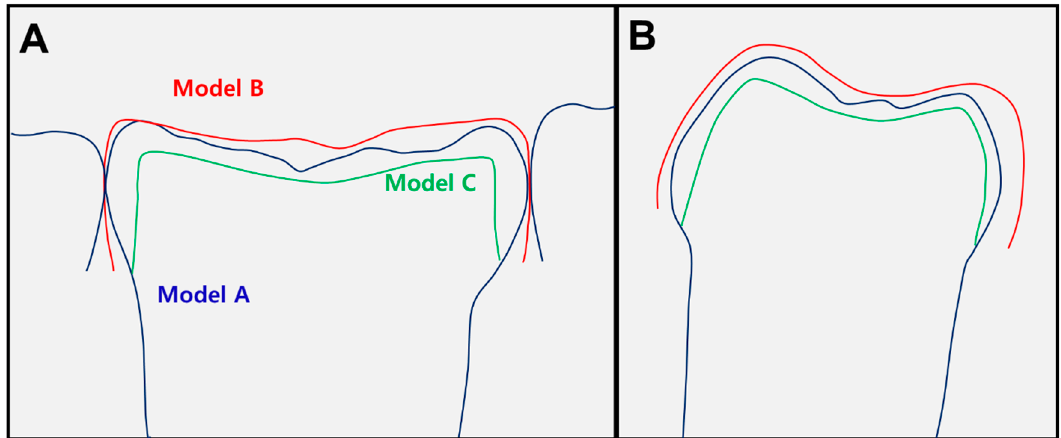
Figure 3. Superimposition of digitally reconstructed models: ( A ) mesiodistal section view of a left mandibular primary second molar; ( B ) buccolingual section view. The blue, red, and green lines represent models A, B, and C, respectively.